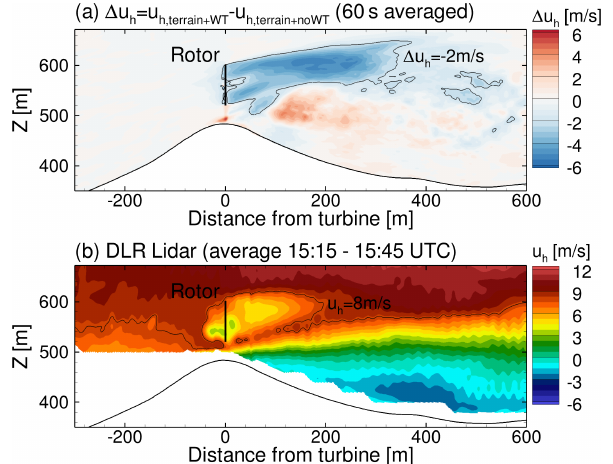
Figure 10. Horizontal component of the line-of-sight velocity in the DLR lidar plane, with the difference between the FLOWer results of the simulation with and without the turbine (a) and measured distribution (b) .